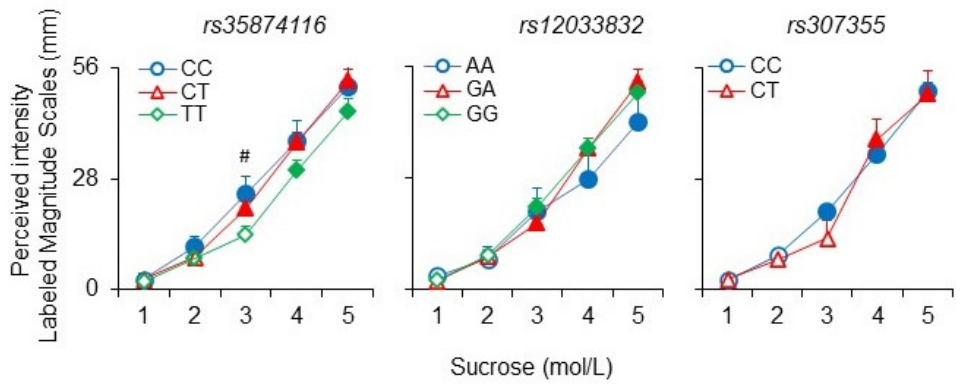
Figure 3. Mean values ± SEM of the perceived intensity ratings after stimulation with five suprathreshold sucrose solutions according to genotypes of rs35874116 and rs12033832 SNPs of TAS1R2 and rs307355 SNP of TAS1R3. The numbers 1, 2, 3, 4, 5 on the X -axis correspond to 0.01, 0.032, 0.1, 0.32, and 1 mol/L concentration, respectively). n = 107. The solid symbol denotes a significant difference with respect to the previous value ( p ≤ 0.037; Fisher LDS, after repeated-measures ANOVA). # indicates a significant difference between the value of CC subjects and the corresponding value of TT subjects ( p = 0.028; Fisher LDS or Duncan’s test, after repeated-measures ANOVA).